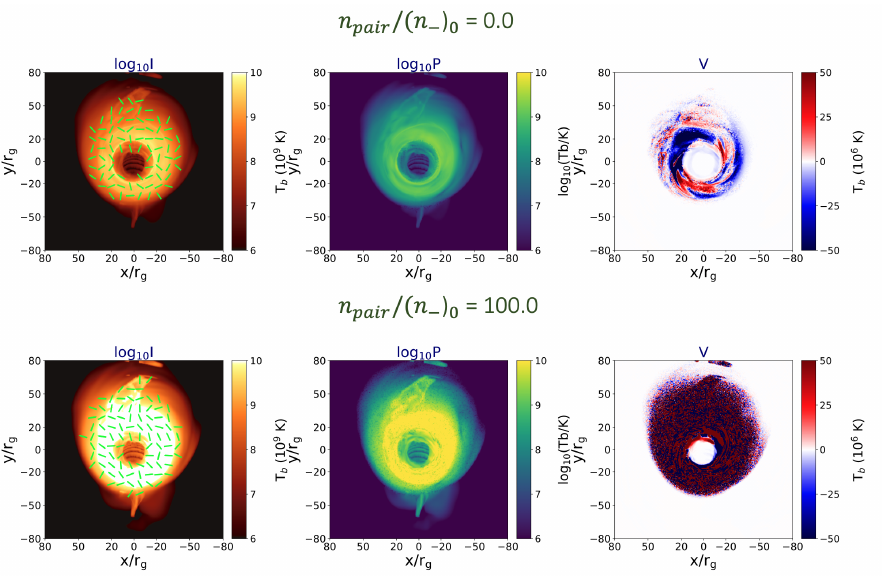
Figure 8. A map from SANE simulations with a = +0.5 at R high = 20 in R-beta model from KHARMA simulations. The top row refers to the case with no positrons while the bottom one describes the case with 100% positrons compared with the original number of electrons. In each row, from the ( left ) to ( right ), we present the images of total intensity, the linear and the circular polarization,